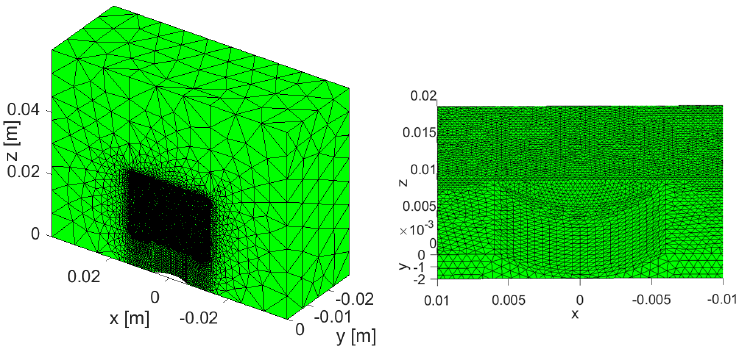
Figure 3. Finite element mesh for cutting simulations (523,928 linear tetrahedrons).